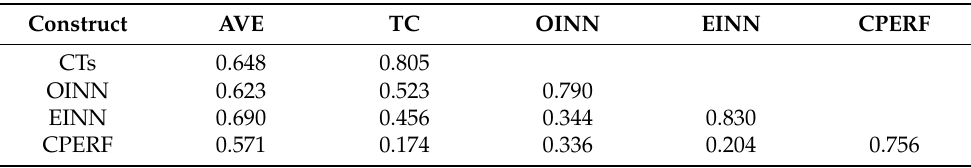
Table 5. Discriminant validity. AVE, average variance extracted.